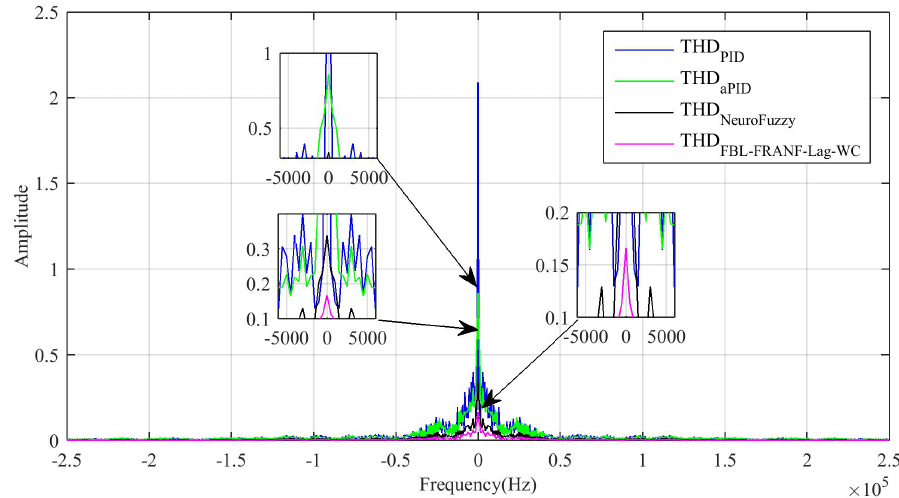
Figure 9. Frequency spectrum of the load current.